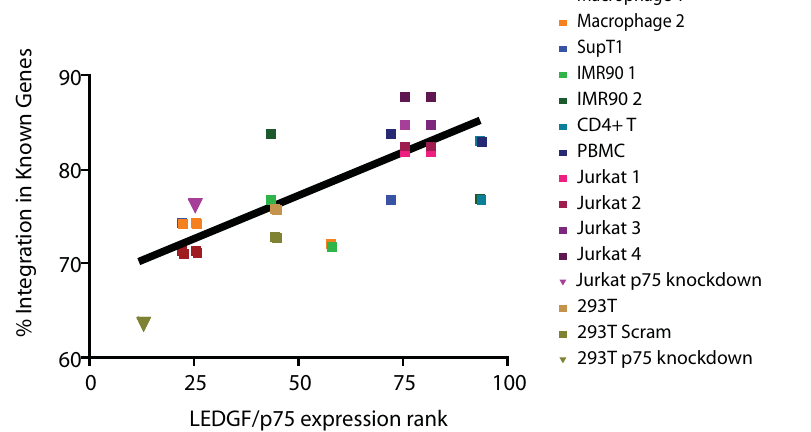
Figure 9. Correlation between LEDGF/p75 expression and the frequency of HIV integration in genes. Data is shown for 15 HIV integration site data sets in 10 cell types. The y-axis shows the percentage of integration events within transcription units of the ‘‘known gene’’ set of human genes for each integration site data set. The x-axis shows relative expression values for LEDGF/p75 derived from Affymetrix array data (see methods for details). The R-squared value for the fit is 0.6148 (P , 0.0001). The references for the data sets used are as follows: Macrophage 1 is the VSV-G set